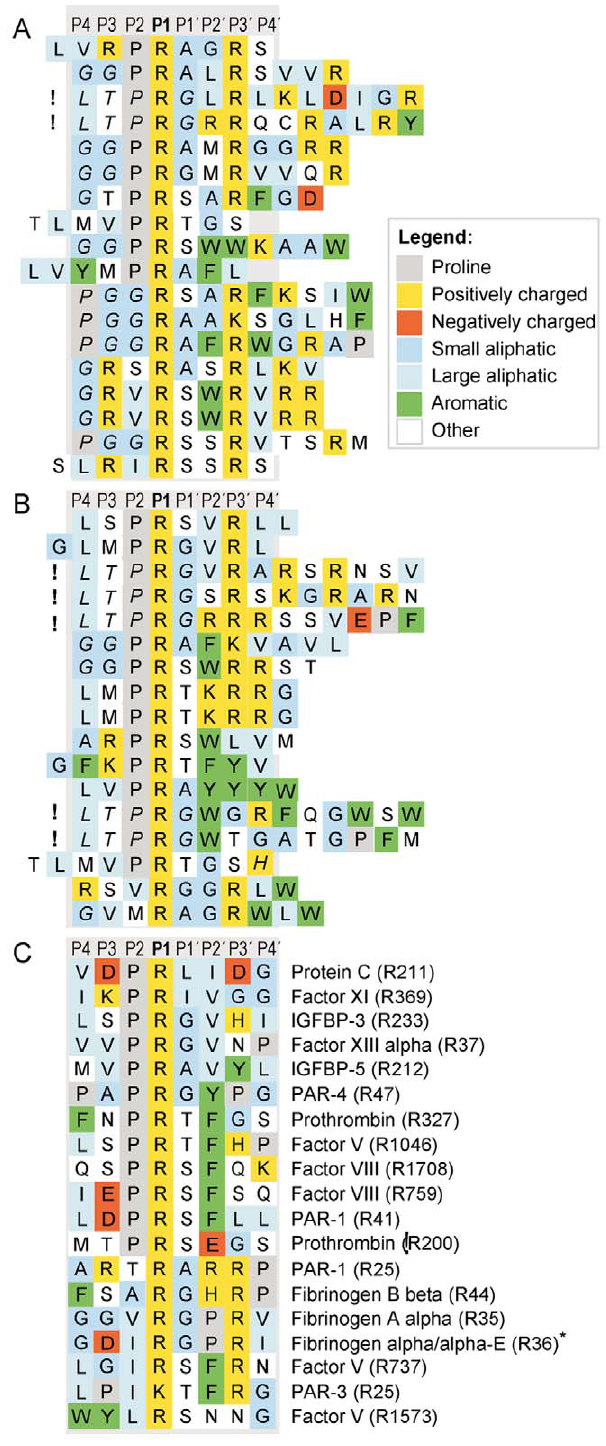
Figure 1. Alignment of sequences obtained after five selection rounds with 1 U of thrombin or 0.2 U of thrombin, compared to natural substrates. Panel A shows the result with 1 U of thrombin, panel B the result with 0.2 U of thrombin and panel C a panel of natural substrates. The P1 residue in natural substrates (after which cleavage occurs) is denoted in parentheses. Substrate sequences refer to Homo sapiens where not indicated otherwise.! marks phage sequences that have LTPRG instead of LTPGG in the N-terminal flank. Residues from the non-randomized phage region are in italics. *, from Rattus norvegicus